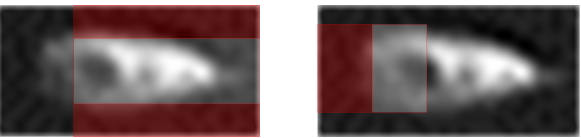
Figure 2: The used Haar-like features from